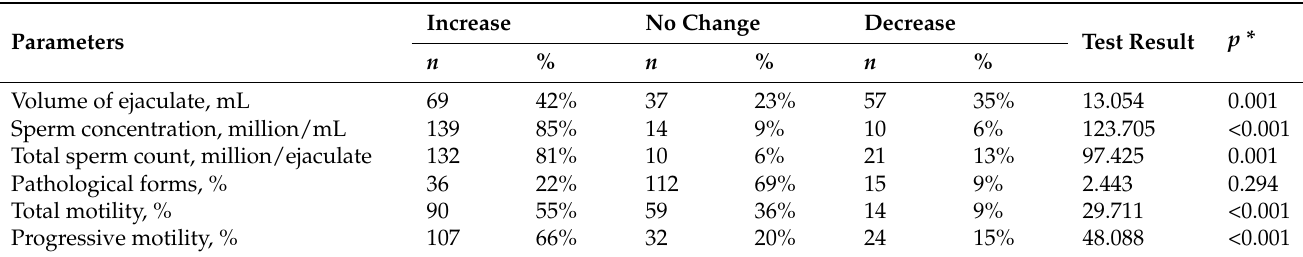
Table 1. Interpretation of the maximal changes observed in sperm parameters after treatment compared to baseline